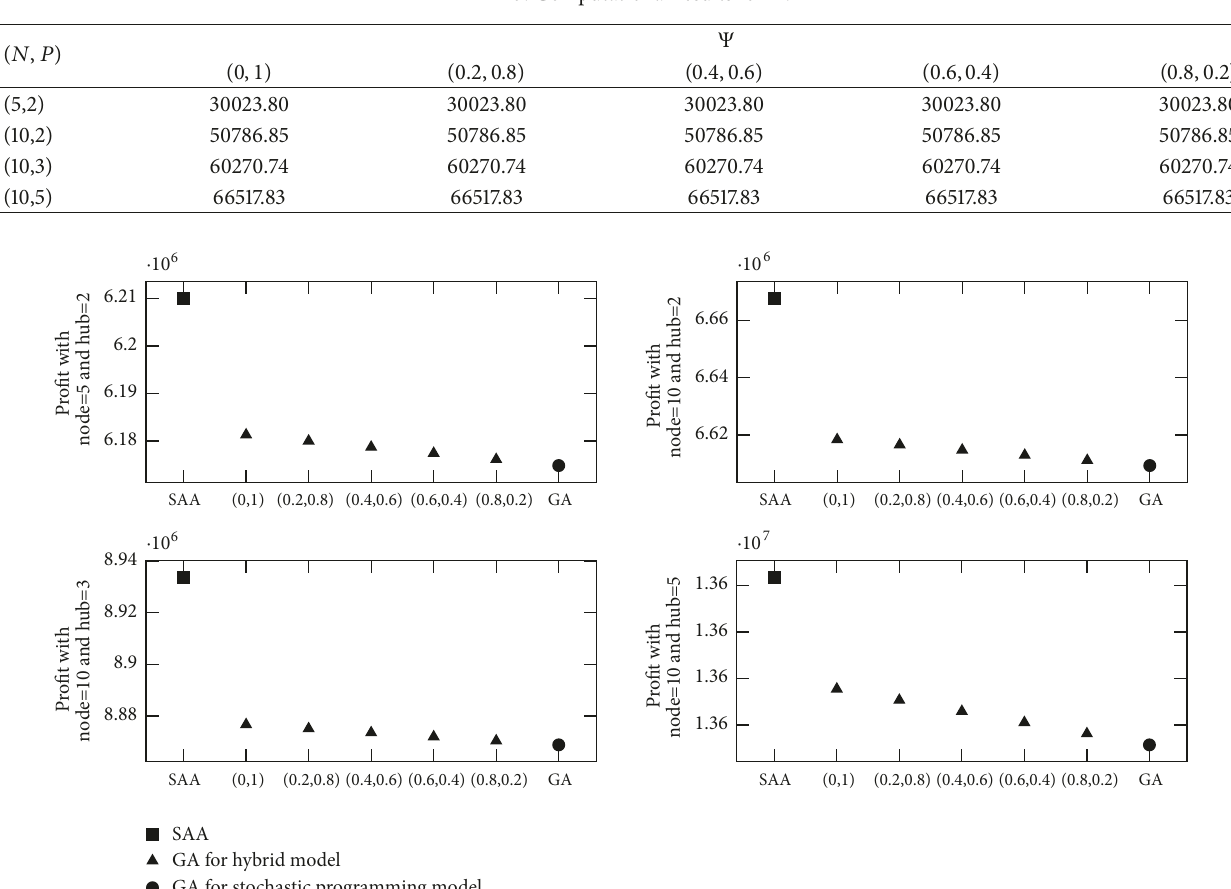
Figure 2: Computational solutions obtained when solving two